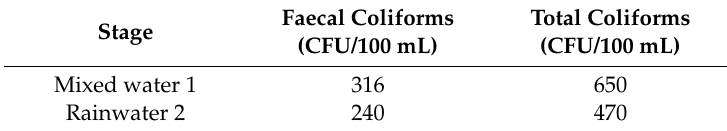
Table 9. Contamination of faecal and total Coliforms for the case